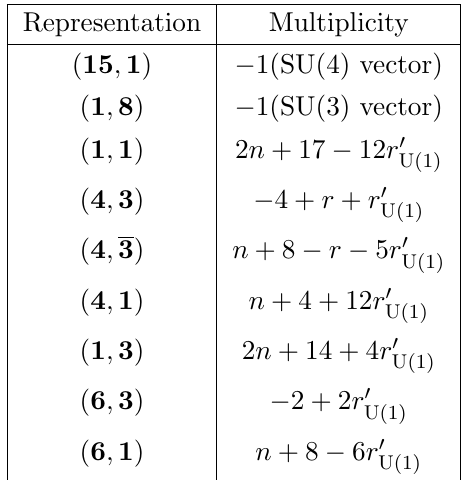
Table 14 . The spectrum for the con(cid:12)guration No.19. H = SU(2) (cid:2) SU(2) (cid:2) U(1).